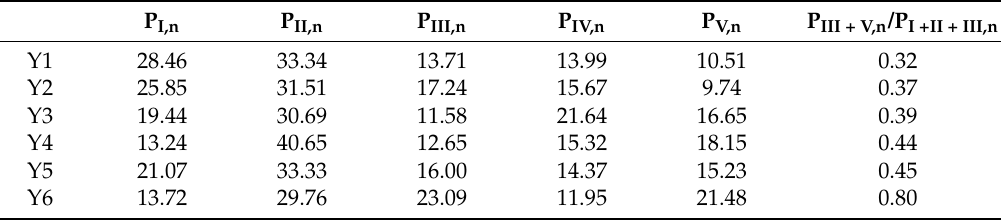
Table 2. Percentage distribution of (f i × 100%) of